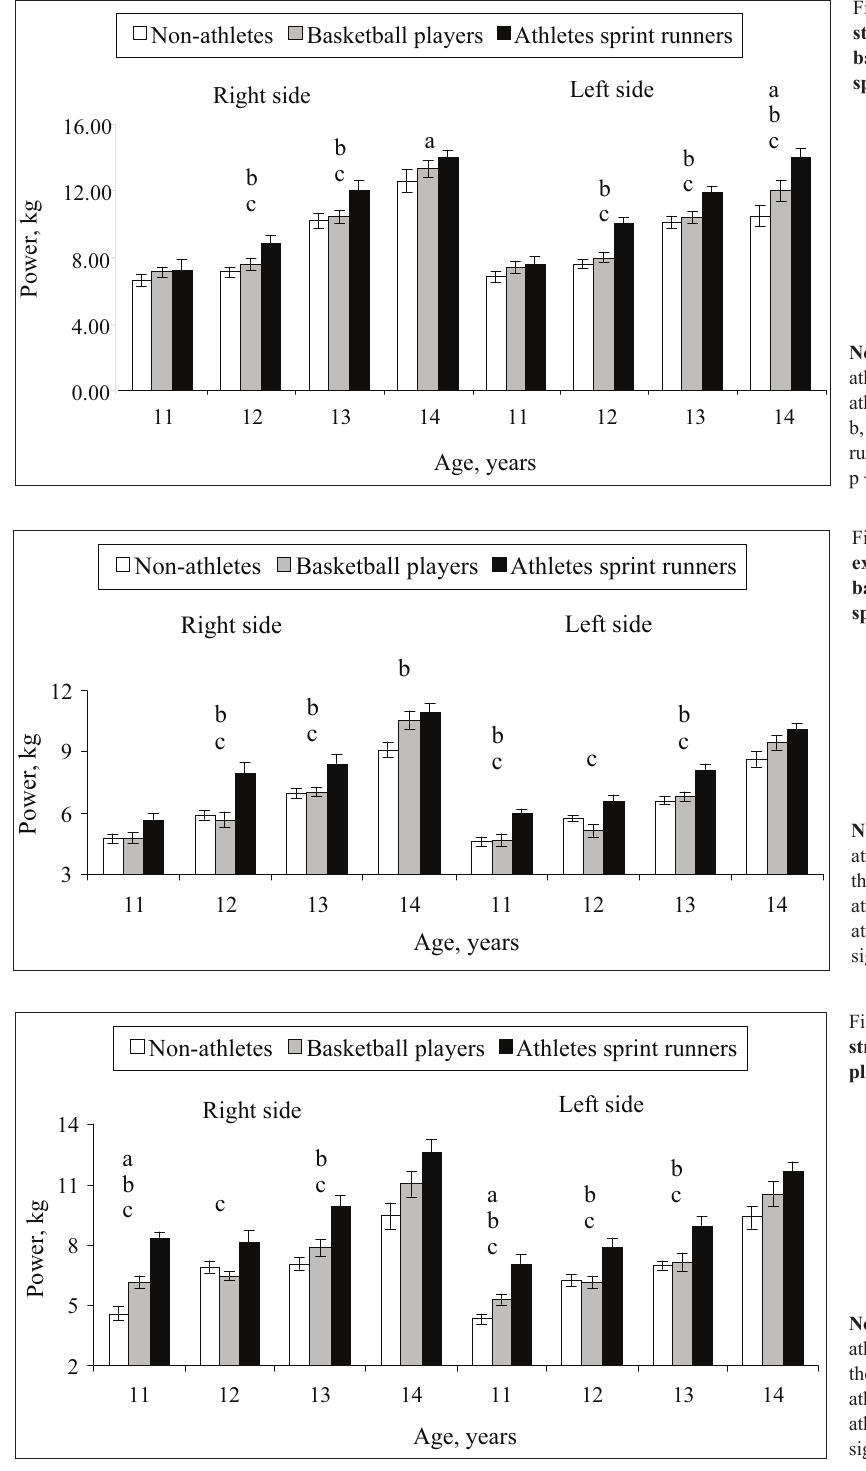
Figure 4. The results of calf flexors strength in the non‑athletes, basketball players and athletes sprint runners